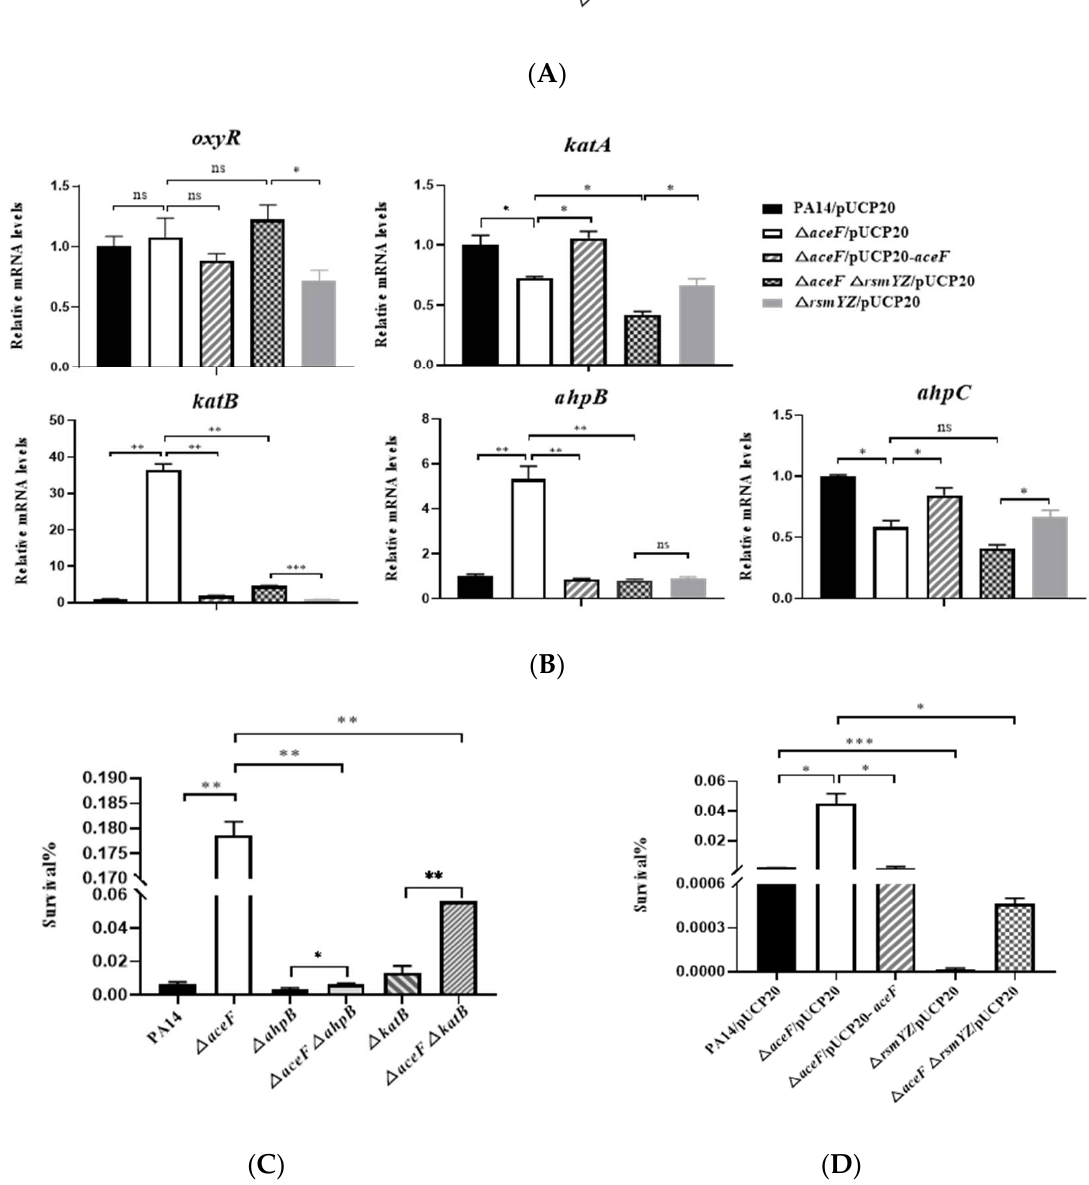
Figure 6. RsmY and RsmZ increase bacterial tolerance to hydrogen peroxide in the Δ aceF mutant. ( A ) Survival rates of bacteria following treatment with 300 mM H 2 O 2 for 1 h. ( B ) The RNA levels of oxyR, katA, katB, ahpB and ahpC were determined by real-time PCR. ( C , D ) survival rates of bacteria following treatment with 300 mM H 2 O 2 for 1 h. Data shown represent mean ± standard error of mean from three samples. * p < 0.05; ** p < 0.01; *** p < 0.001 by ANOVA.